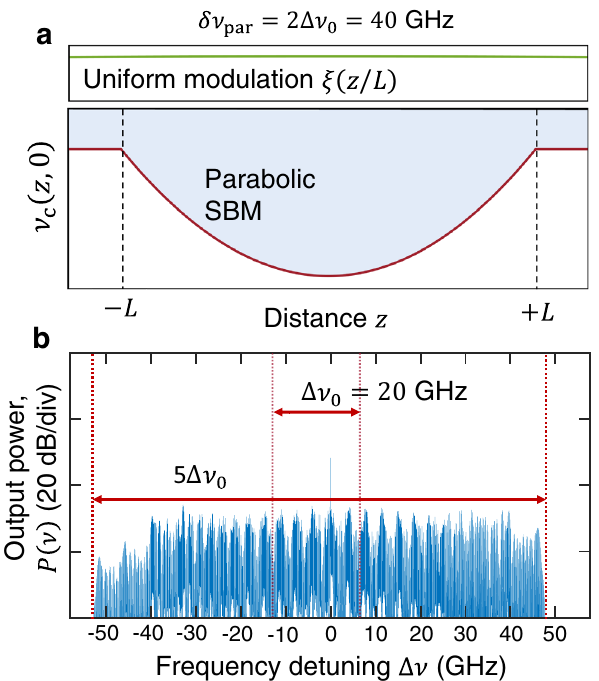
Fig. 4 Optical frequency comb (OFC) generated by a uniform adiabatic modulation with amplitude exciding the bandwidth of the SNAP bottle microresonator (SBM). a Adiabatic modulation of the parabolic SBM (red (cid:1) (cid:3) line) with a uniform spatial distribution ξ z = L (green line). The maximum amplitude of the modulation is δ ν par ¼ 2 4 ν 0 ¼ 40 GHz. b The generated OFC has a bandwidth fi ve times larger than that of the SBM, 4 ν 0 ¼ 20 GHz. The number of comb lines generated are